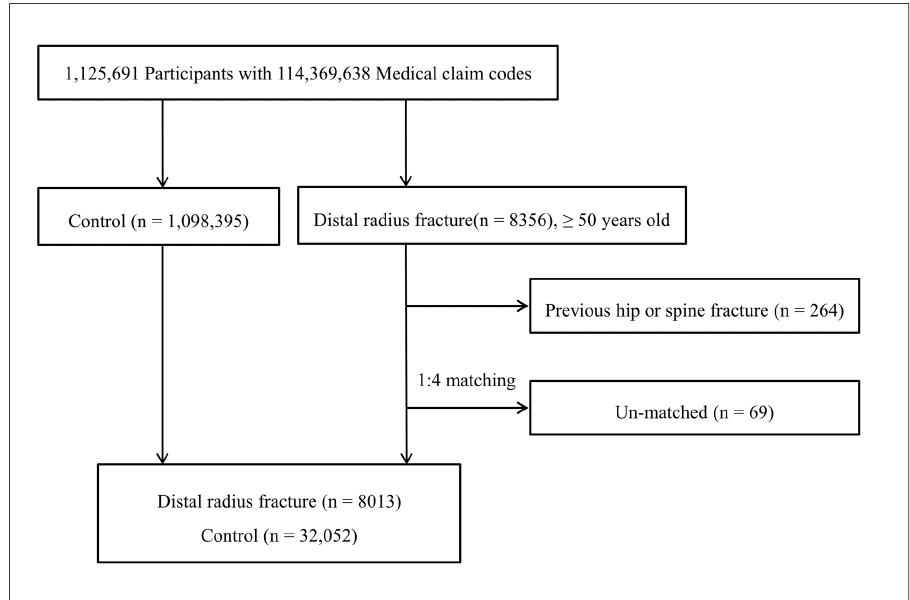
Figure 1. A schematic illustration of the participant selection process that was used in the present study; 8013 distal radius fracture patients and 32,052 control participants were included. Age, sex, level of income, and region of residence were matched between the distal radius fracture patients and the control participants (Table 1). The past medical histories (hypertension, diabetes mellitus, and dyslipidemia) were also matched. The mean follow- up was 78.3 months (standard deviation (SD) = 32.2) in the distal radius fracture group and 78.4 months (SD = 32.1) in the control group. During the follow-up period, a difference in the occurrence of hip fractures between the distal radius fracture group and the control group was observed (Figure 2). Additionally, a difference in the occurrence of spinal fractures between the distal radius fracture group and the control group was observed (Figure 3). The crude and adjusted HRs for hip fracture were 1.61 (95% CI = 1.40–1.86, p < 0.001) and 1.51 (95% CI = 1.30–1.74, p < 0.001), respectively (Table 2). The crude and adjusted HRs for spinal fracture were 1.55 (95% CI = 1.43–1.6, p < 0.001) and 1.40 (95% CI = 1.29–1.52, p < 0.001),